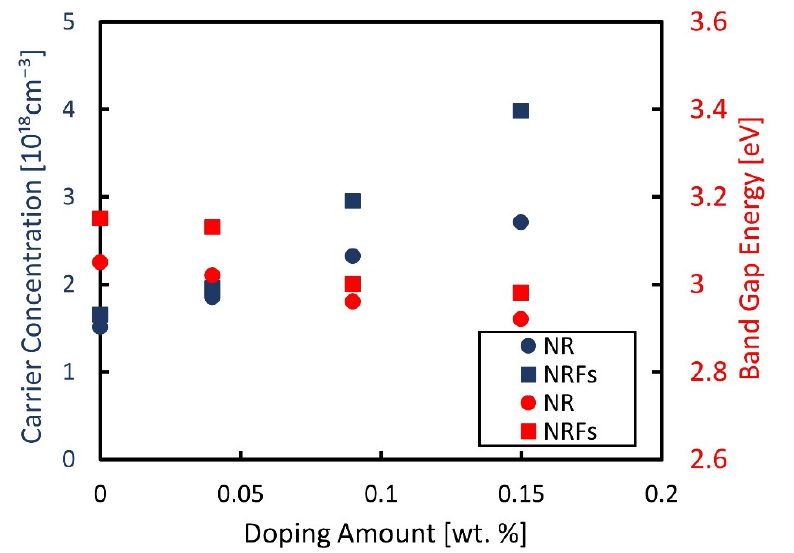
Figure 3. Measured carrier-concentration and evaluated band-gap energy as a function of wt.% of AgNO 3 . The filled blue and red points represent the measured carrier-concentration and the band-gap energy, respectively. The fi lled circle ● and square ■ represent the NR and NRFs samples, respectively.